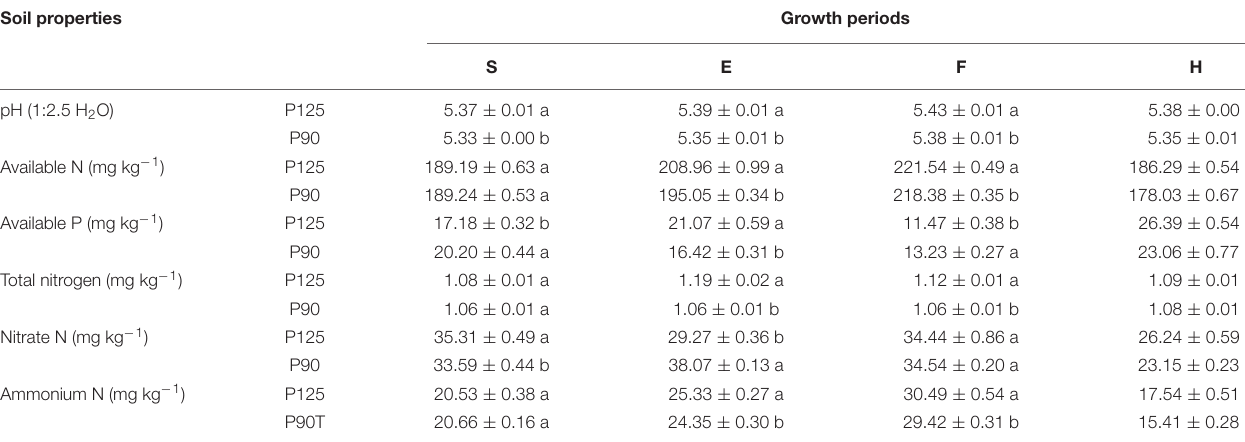
TABLE 1 | Soil biogeochemical properties in the four growth stages of maize—seedling stage (S), ear stage (E), flowering stage (F), and harvest stage (H)—under conventional treatment (P125, rate of 125 kg P 2 O 5 ha − 1 ) and optimal treatment (P90, rate of 90 kg P 2 O 5 ha − 1 ). Soil